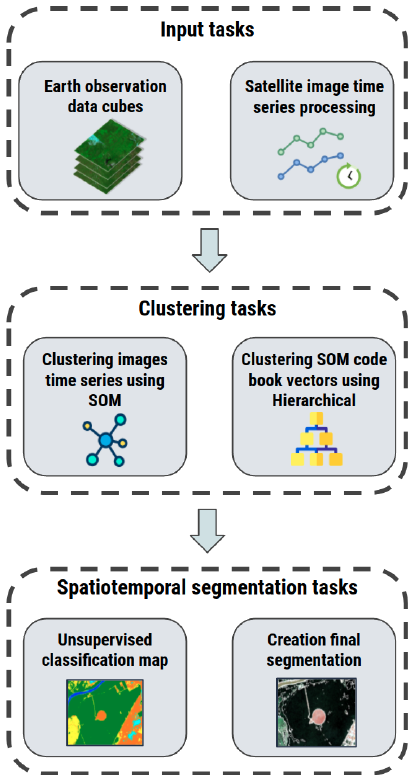
Figure 1. Methodology for spatiotemporal segmentation of satellite image time